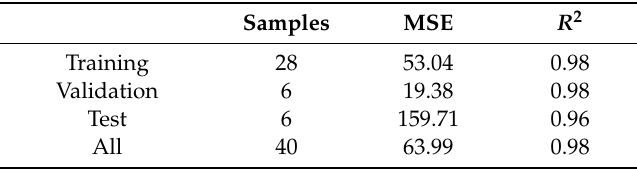
Figure 15. ( a ) Validation of the ANN model of tapped bulk density; ( b ) Performance of the ANN model of tapped bulk density. Table 4. Results of the ANN model of tapped bulk